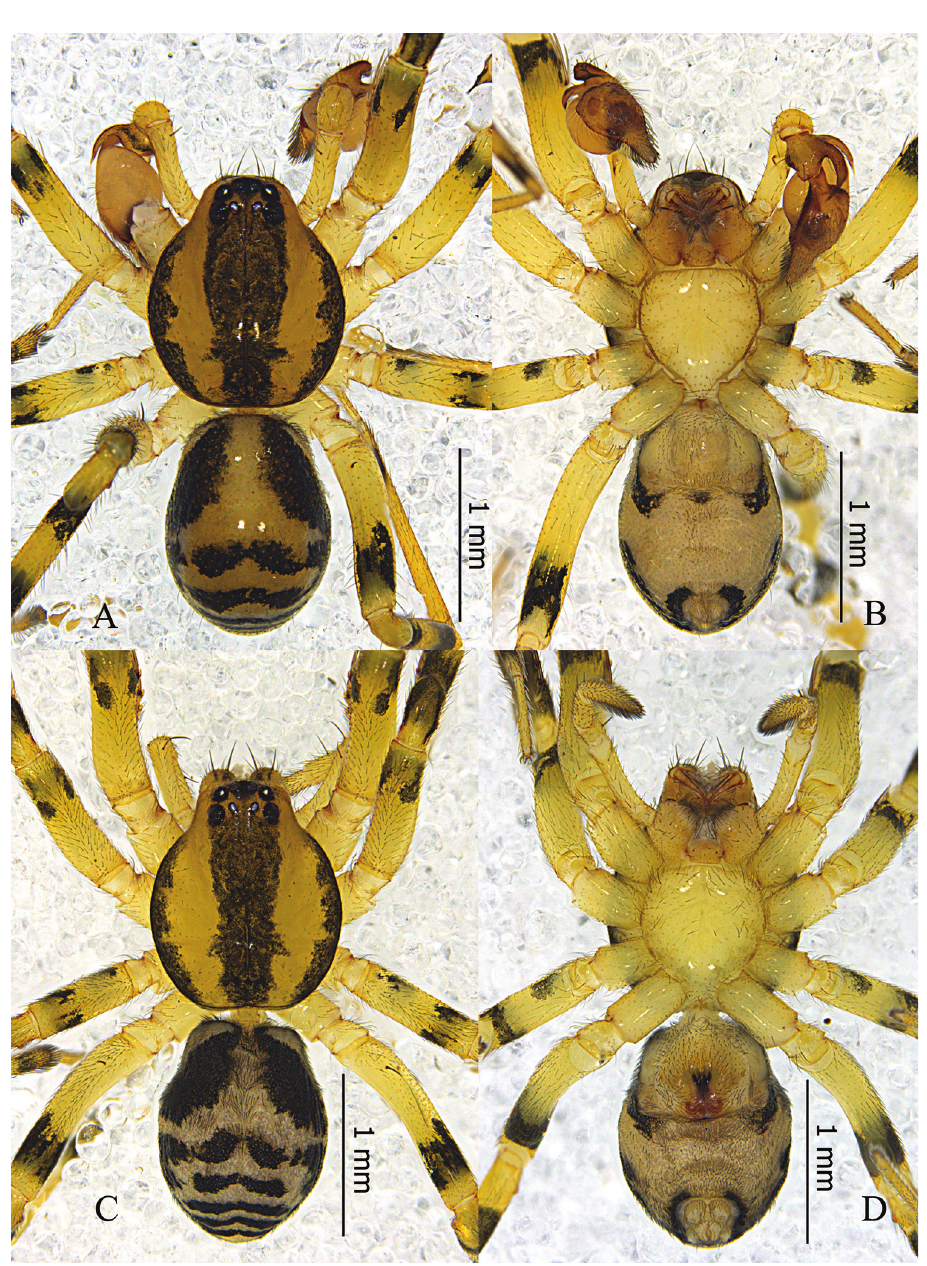
Figure 7. Otacilia curvata sp. n. A male habitus, dorsal view B same, ventral view C female habitus, dorsal view D same, ventral